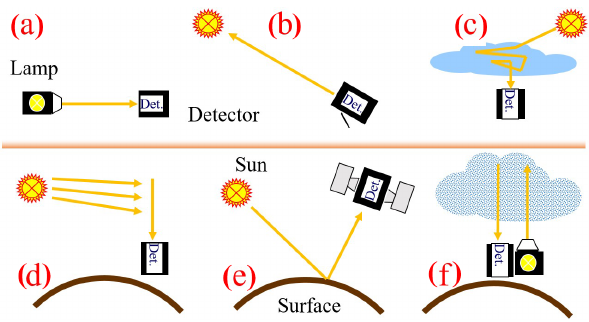
Figure 4. Principles of spectroscopic techniques for GHG mon- itoring. Active measurement techniques (a, f) use artificial light sources, and passive measurement techniques (b–e) use natural light sources such as the sun to monitor